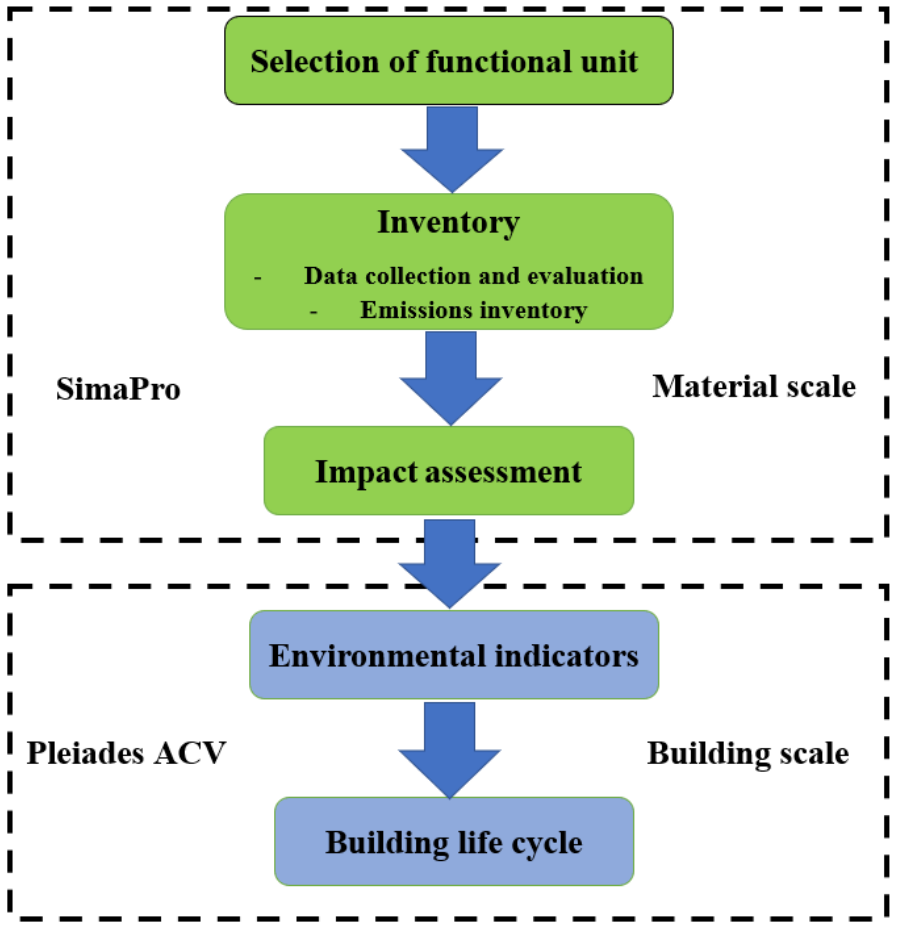
Figure 6. Steps in the LCA process.